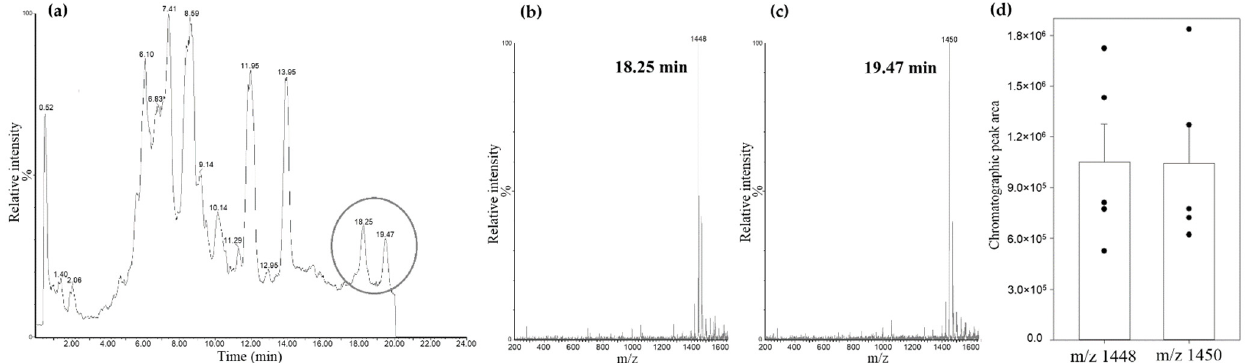
Figure 5. Rat kidney mitochondrial lipid fraction UPLC-MS analysis. ( a ) total scan chromatogram (negatively charged lipids); ( b ) mass spectrum at 18.25 min retention time; ( c ) mass spectrum at 19.49 min retention time; ( d ) comparison of cardiolipins’ m/z 1448 and m/z 1450 chromatographic peak areas, ( n = 5, dots represent values of each experiment, means ± standard